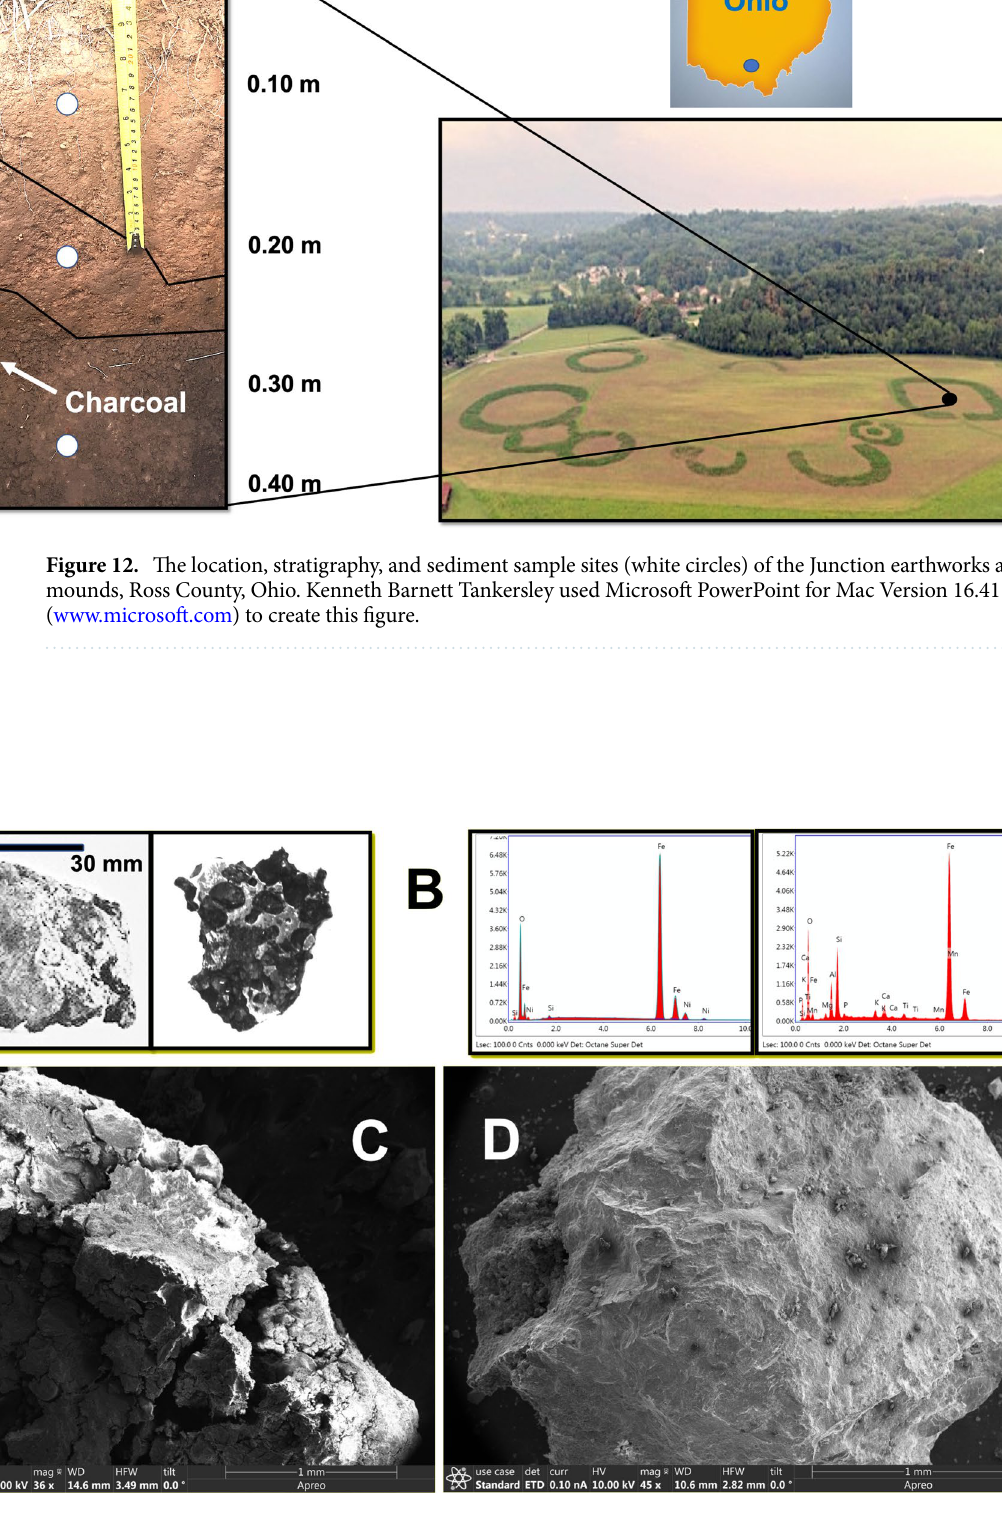
Figure 13. Pallasite meteorites from the Turner village site. (A) Pallasites excavated from the Turner village site in 1882 by Dr. Charles Louis Metz. (B) Energy Dispersive X-Ray Spectroscopy (EDS) of recently discovered pallasites from the Turner village site. (C and D) Scanning electron micrographs of recently excavated pallasites from the Hopewell habitation surface of the Turner village site. Kenneth Barnett Tankersley used Microsoft PowerPoint for Mac Version 16.41 (www. micro soft. com) to create this